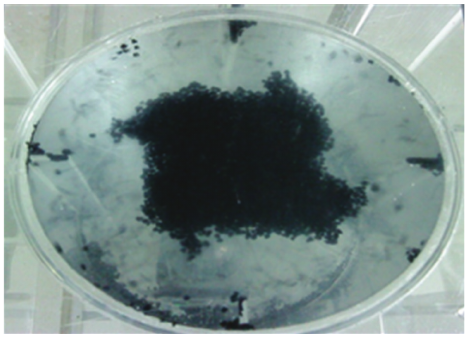
Figure 11: Particle distribution by